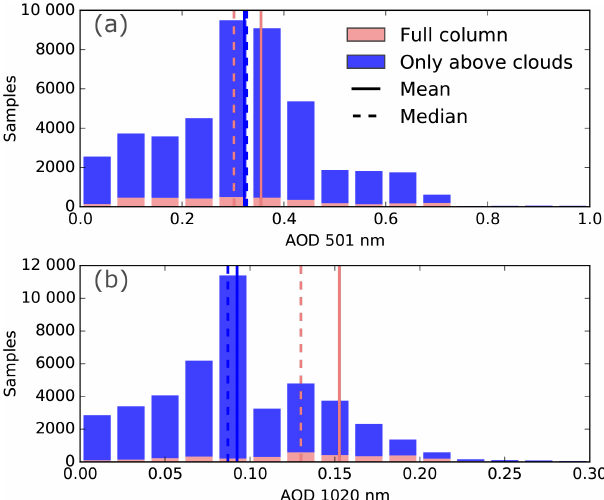
Figure 4. Histograms of above-cloud (blue) and full-column (pink) AOD sampled by 4STAR at (a) 501nm and (b) 1020nm. “Full column” denotes sampling below an altitude of 0.6km where no cloud is between 4STAR and the sun ( N = 3388), while “Only above clouds” denotes the AOD flagged to be only above clouds (see Sect. 3.1, N = 41189). Vertical solid lines denote the mean of the distribution (colored accordingly), while dashed vertical lines denote the